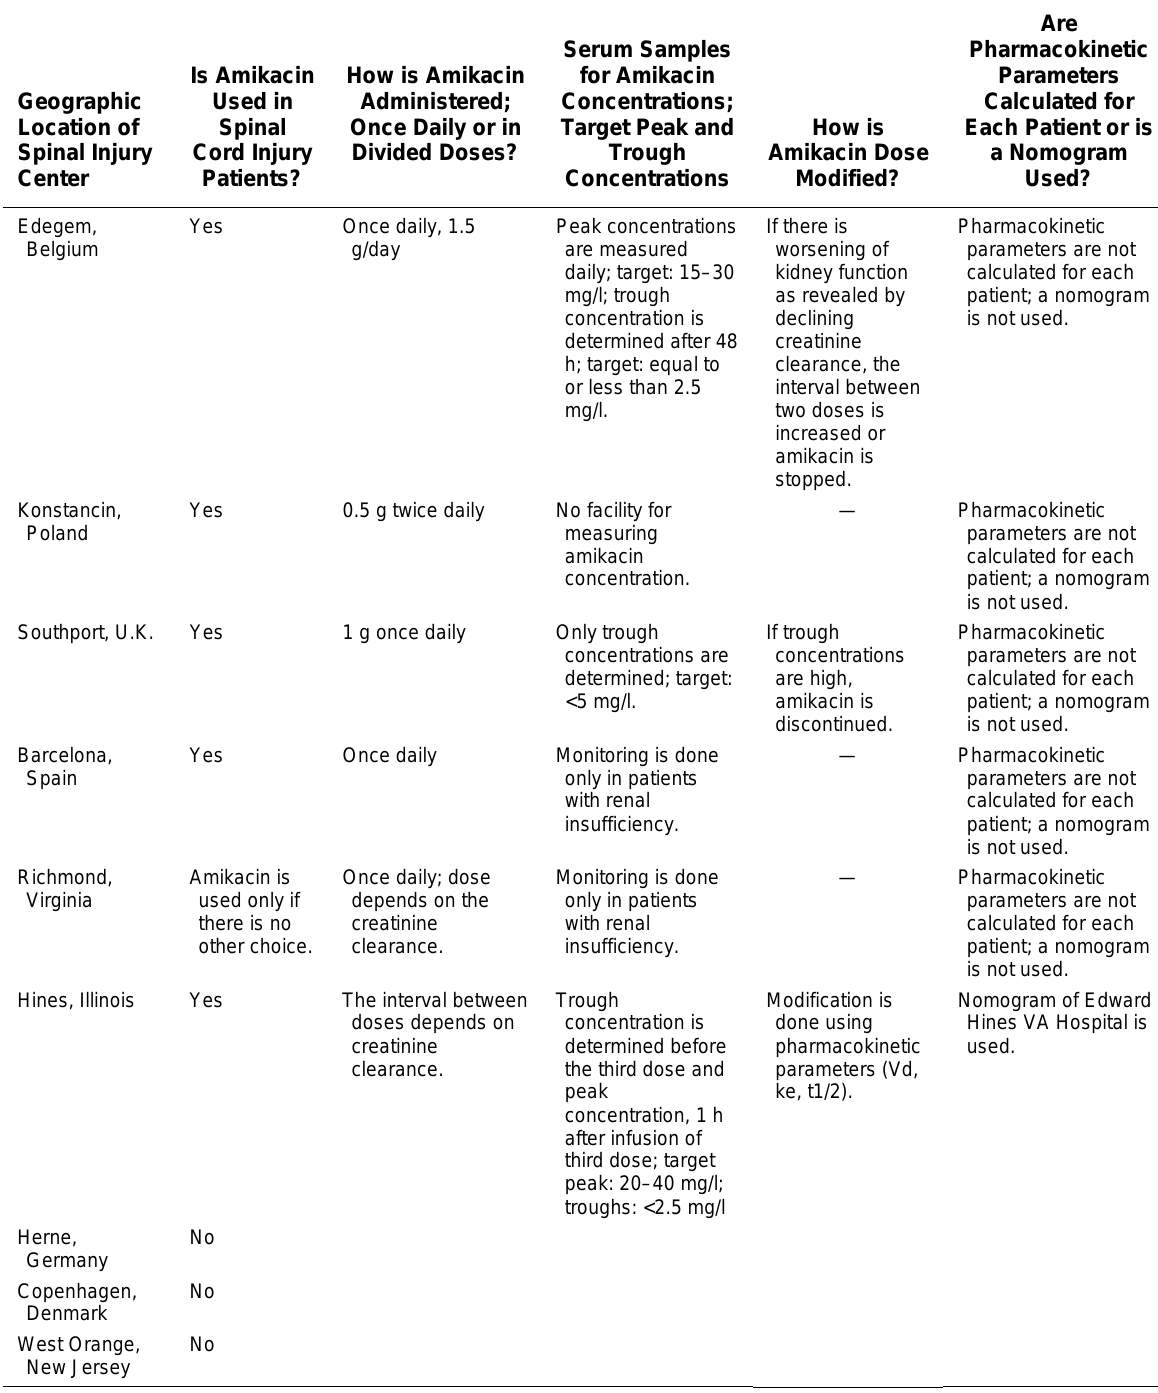
Summary of Clinical Practice Relating to Administration of Amikacin to Spinal Cord Injury Patients in Different Spinal Injury Centers of Europe and the